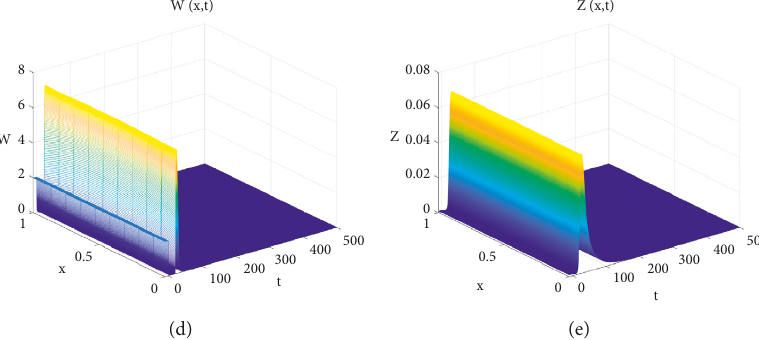
Figure 2: Taking β � 0 . 15, β � 0 . 01, c � 0 . 01, m � 0 . 001, δ � 0 . 5, h � 1 . 5, a � 0 . 5, k � 0 . 4, and b � 0 . 2, we have 1 2 R � 52 . 5251 > 1 ,R � 0 . 7495 < 1, and R � 0 . 7977 < 1, E � ( 20 . 4000 , 17 . 7278 , 2 . 2484 , 0 , 0 ) is asymptotically stable. 0 1 2 1